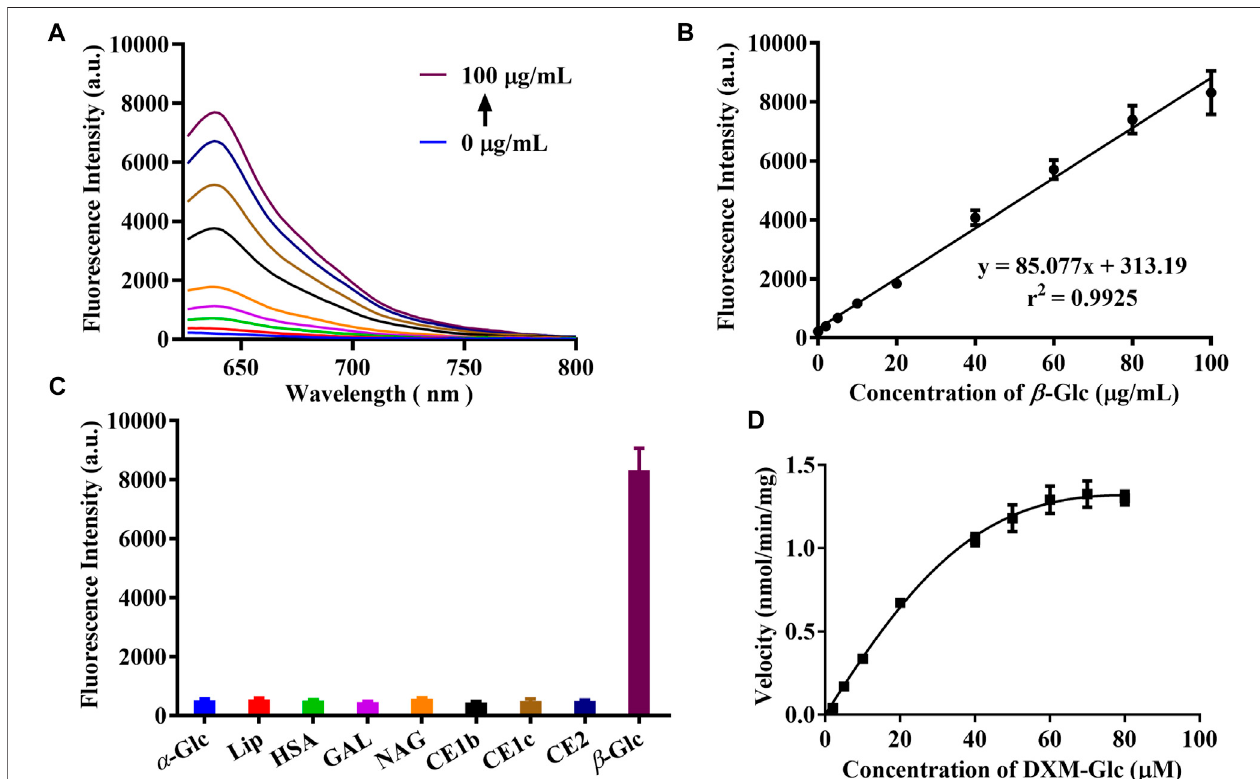
FIGURE 2 | (A) The fl uorescence response of DXM-Glc toward β -Glc with different concentrations (0 – 100 μ g/ml). (B) The linear relationship between the fl uorescence intensity and β -Glc concentrations. (C) The fl uorescence response of DXM-Glc toward different enzymes. (D) The hydrolysis kinetics of DXM-Glc mediated by β